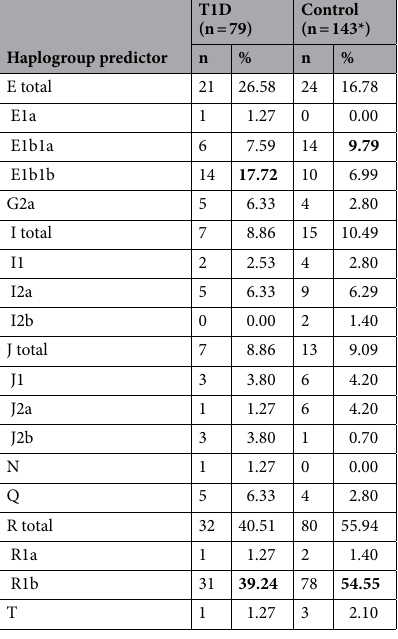
Table 3. Y-chromosome haplogroups of the Maranhão state T1D and control groups. Bold indicates the most prevalent Y haplogroups. T1D = type 1 diabetes. *In 3 samples the Y haplogroup determination was not obtained due quality control.